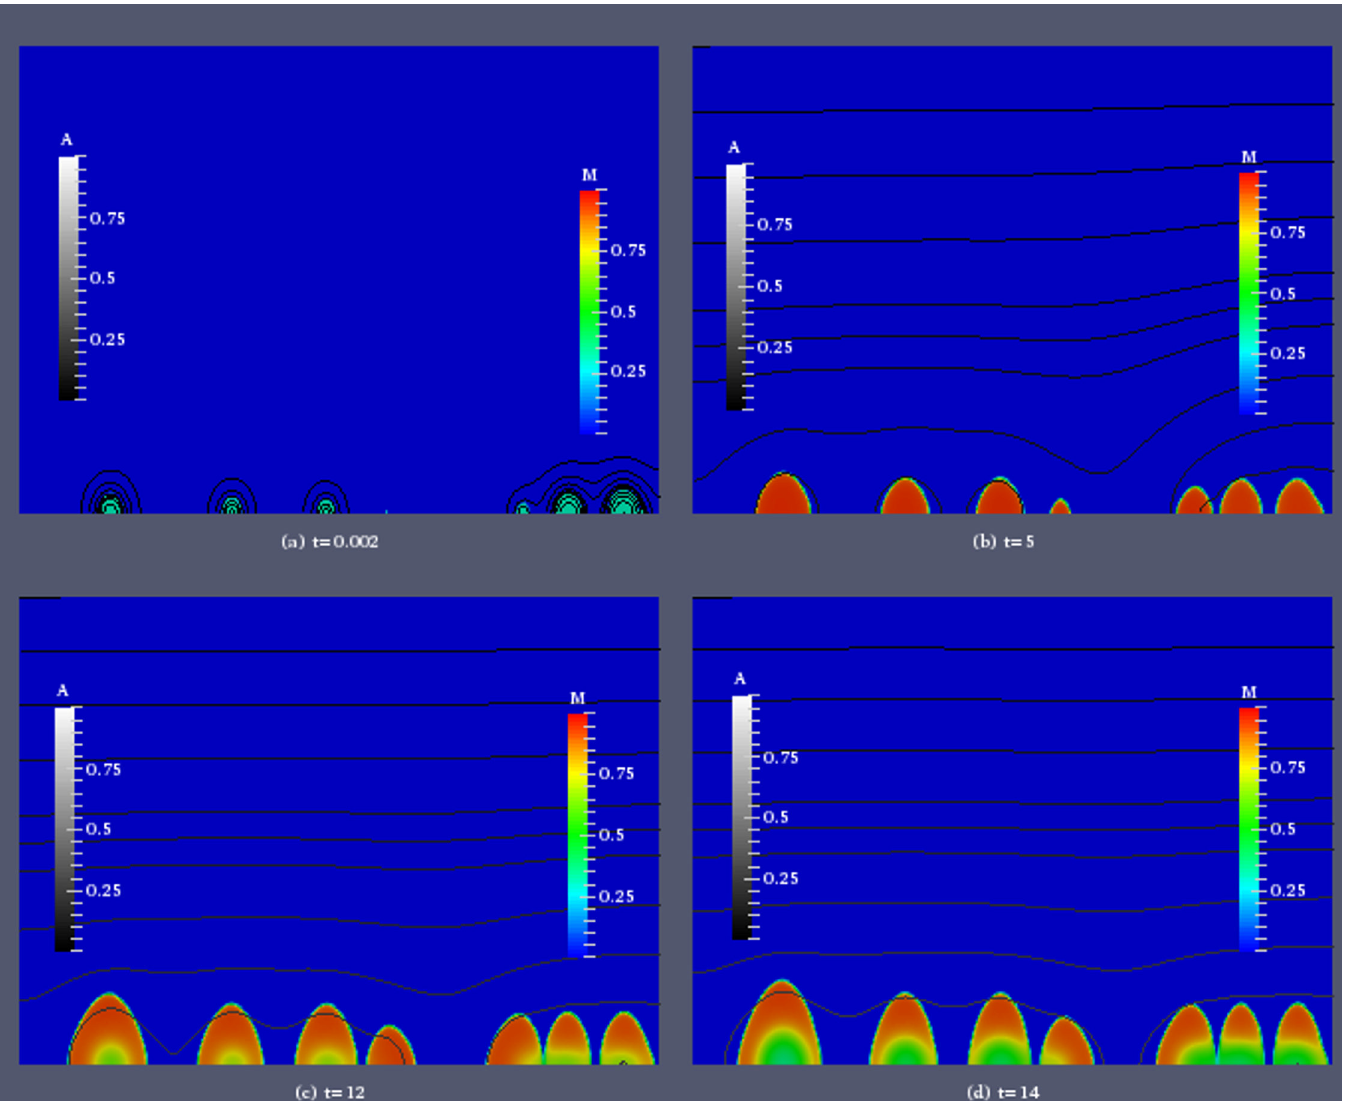
Fig 7. Simulation of biofilm growth for induction threshold τ = 60 nM and maximum dispersal rate η 1 = 3.6 d − 1 . Color coded is the biomass density M , iso-lines of the autoinducer concentration A are plotted in